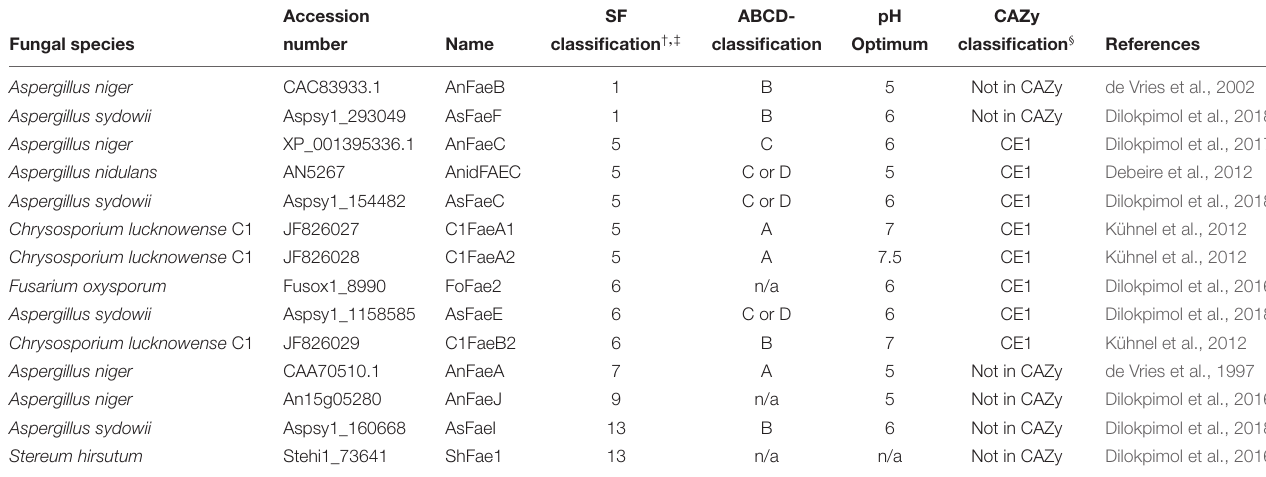
TABLE 1 | Overview of FAEs employed in this study including fungal origin, accession number, name identification, classification according to the SF and ABCD